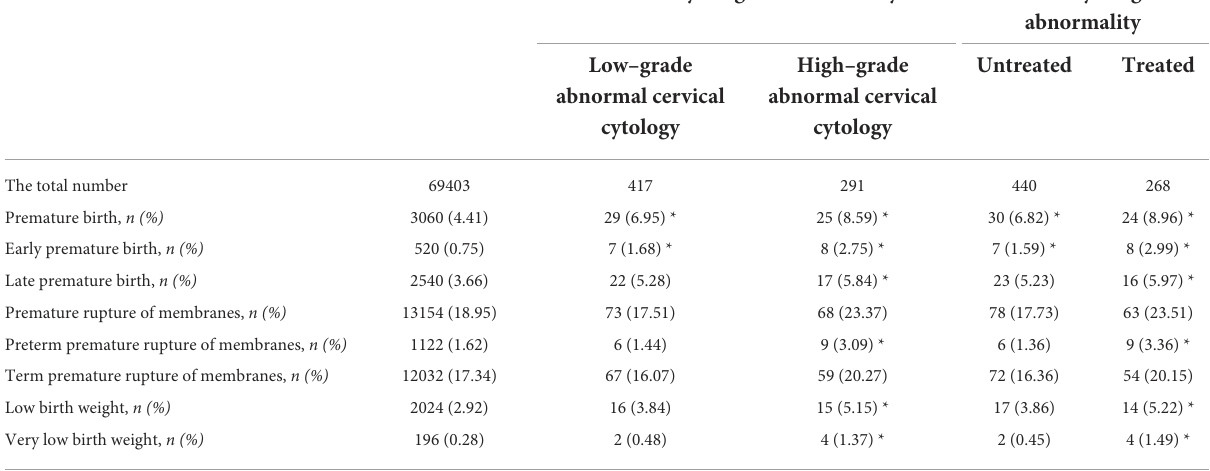
TABLE 3 Associations between different classifications of cervical cytological abnormality and adverse outcomes. Normal cervix Cervical cytological abnormality Cervical